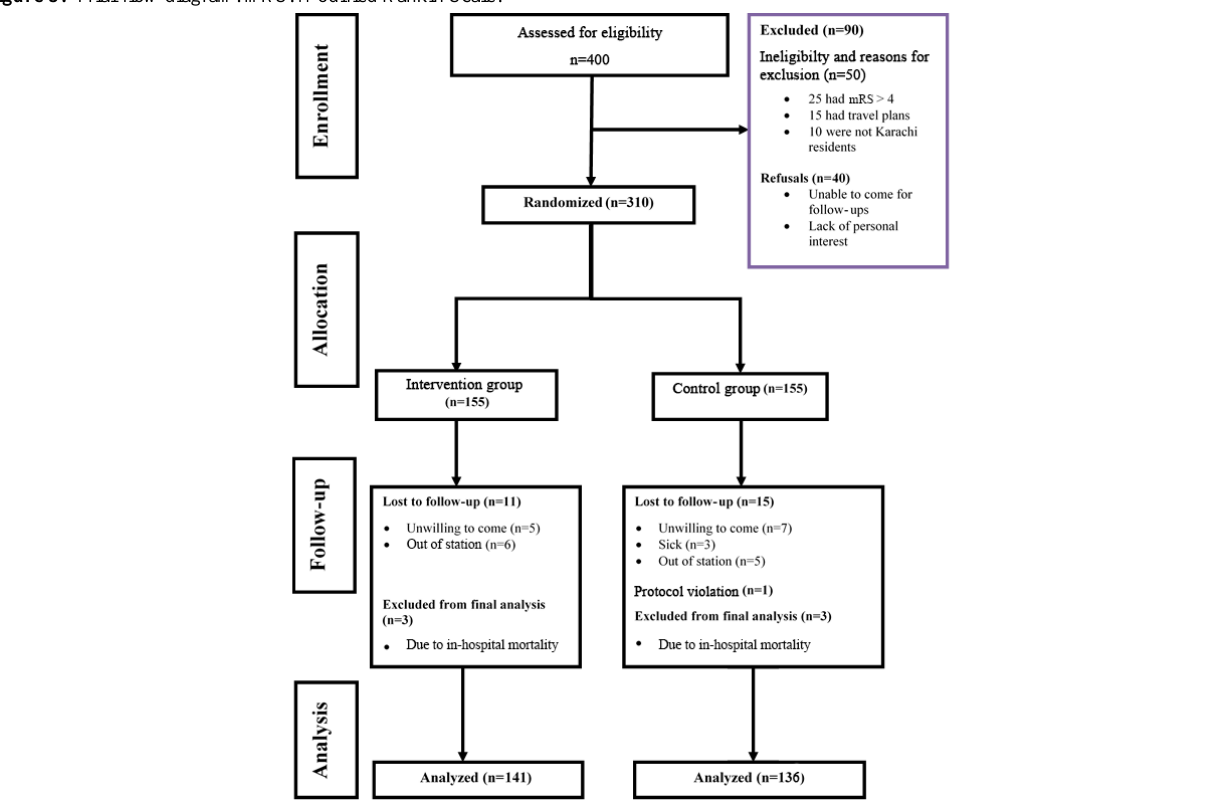
Figure 3. Trial flow diagram. mRS: Modified Rankin